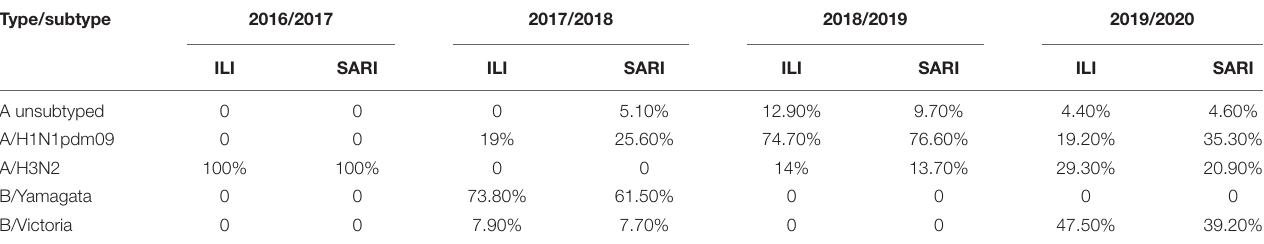
TABLE 2 | Comparison of the number of positive ILI and SARI samples with the predominant virus type of each consecutive influenza